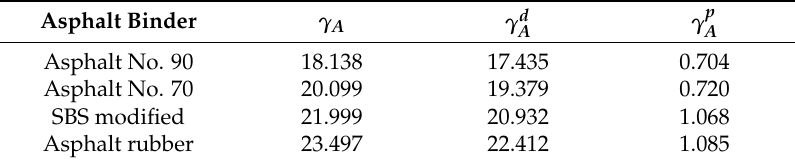
Table 4. Surface energy of the asphalt binders at 25 ◦ C (MJ/m 2 ).